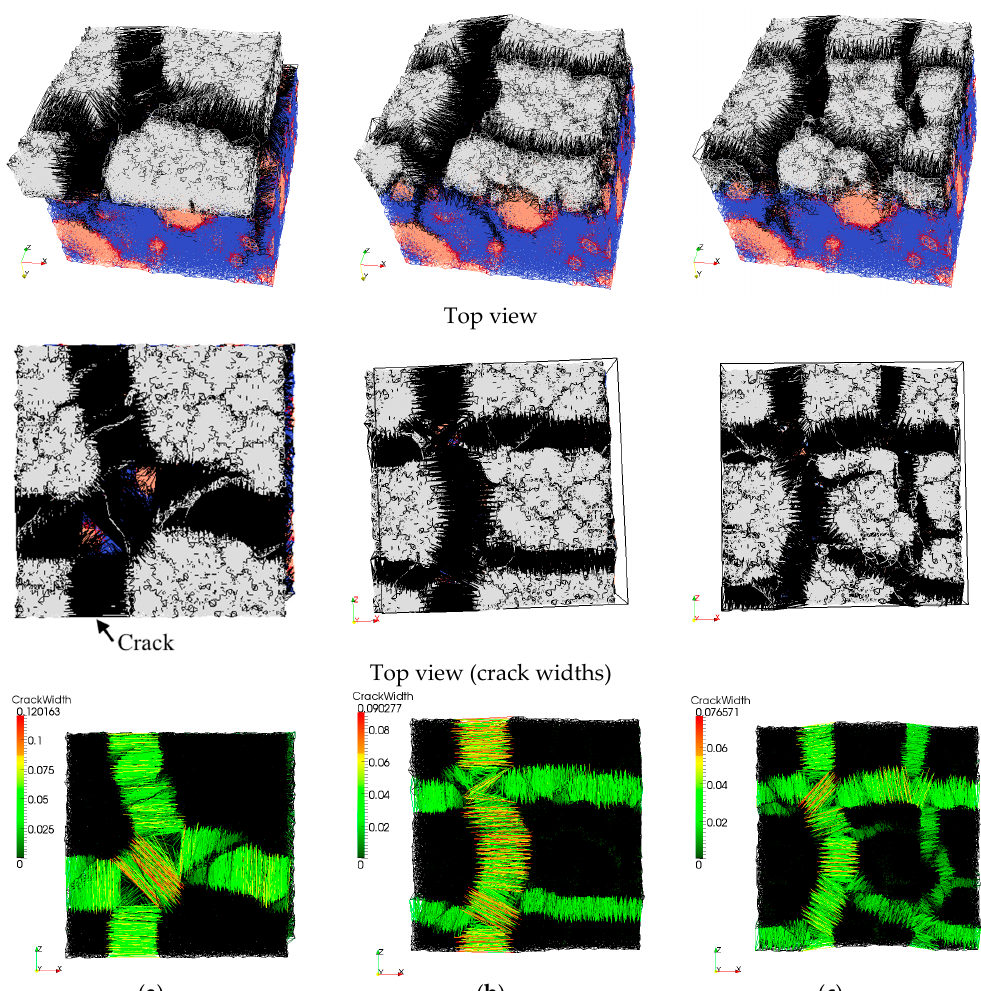
Figure 8. Influence of bond strength and substrate roughness on cracking after 110 days of drying, side and top view: white—repair material, blue—substrate, black—cracks, orange—aggregates, red—ITZ; top view (crack widths): colours as indicated in the legend ( a ) Smooth surface, interface strength 1 MPa; ( b ) Rough surface, interface strength 1 MPa; ( c ) Rough surface, interface strength 3 MPa.